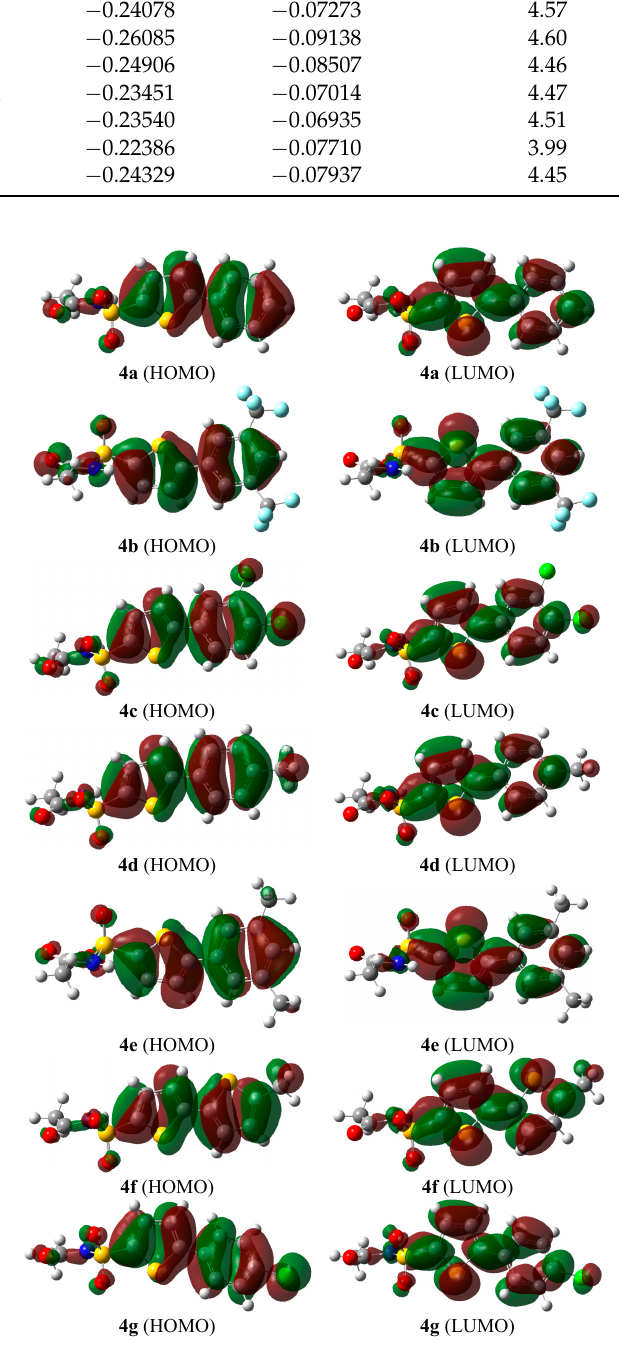
Figure 1. HOMO-LUMO surfaces of all products 4a – g .